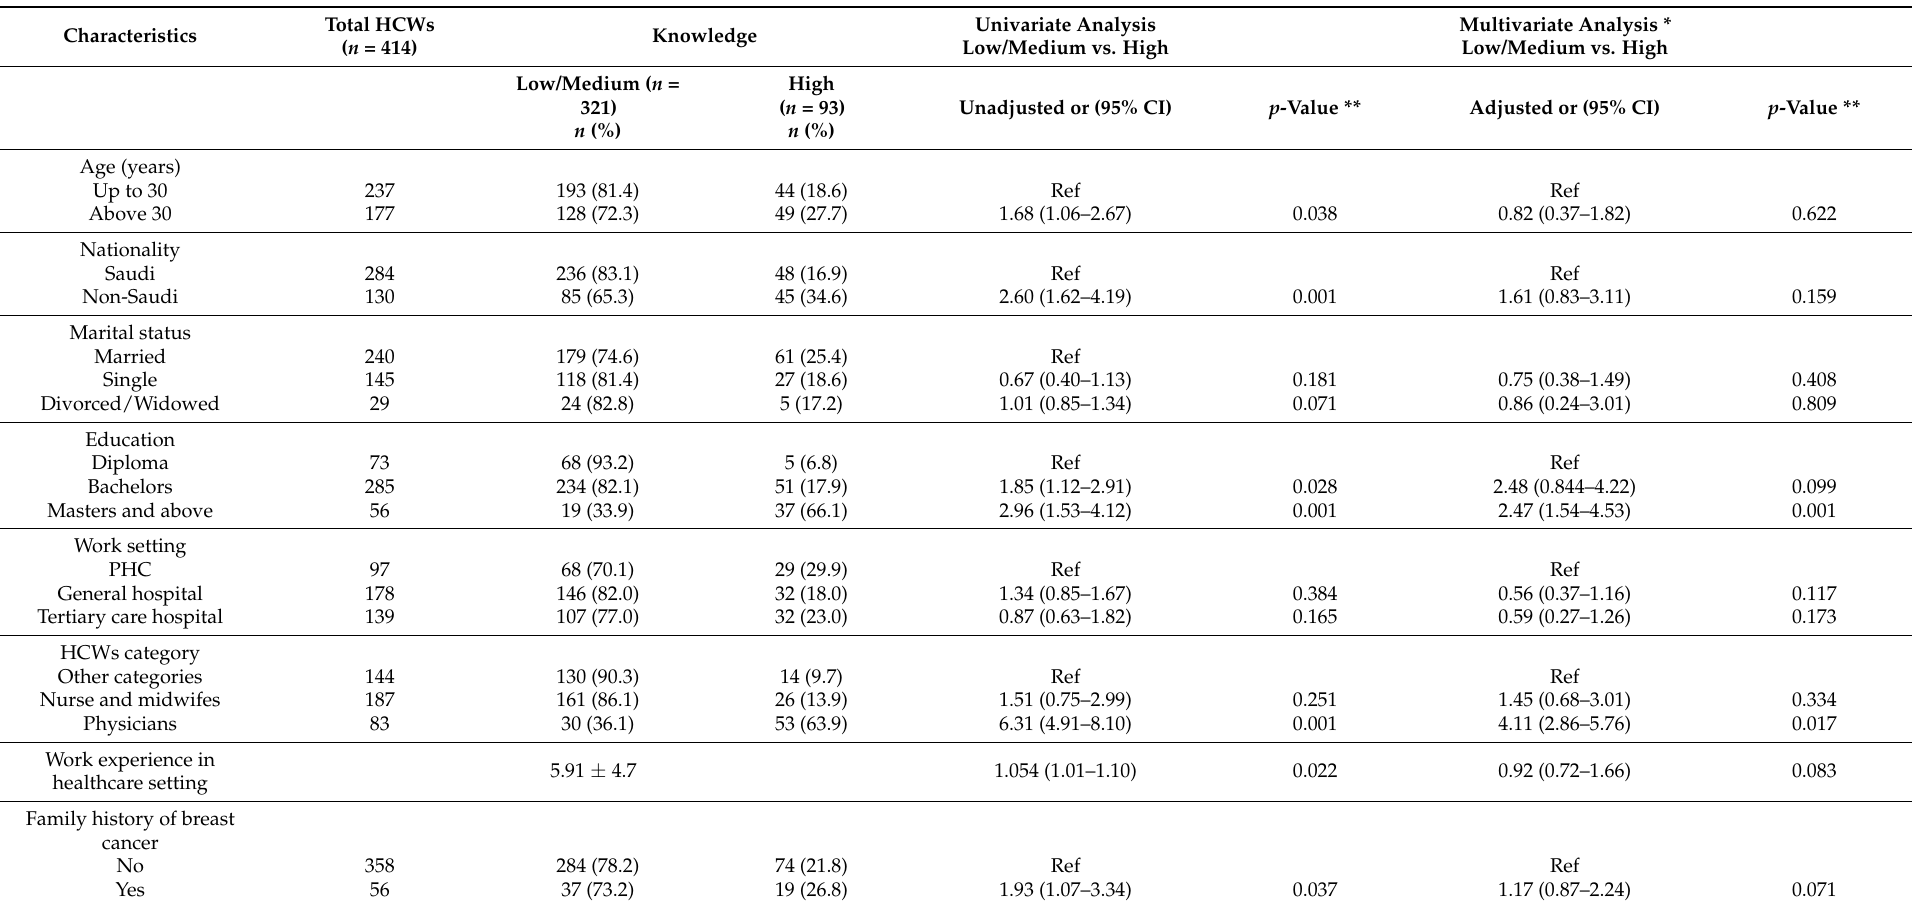
Table 4. Binomial regression analysis between participants’ socio-demographic characteristics and knowledge towards breast cancer ( n =